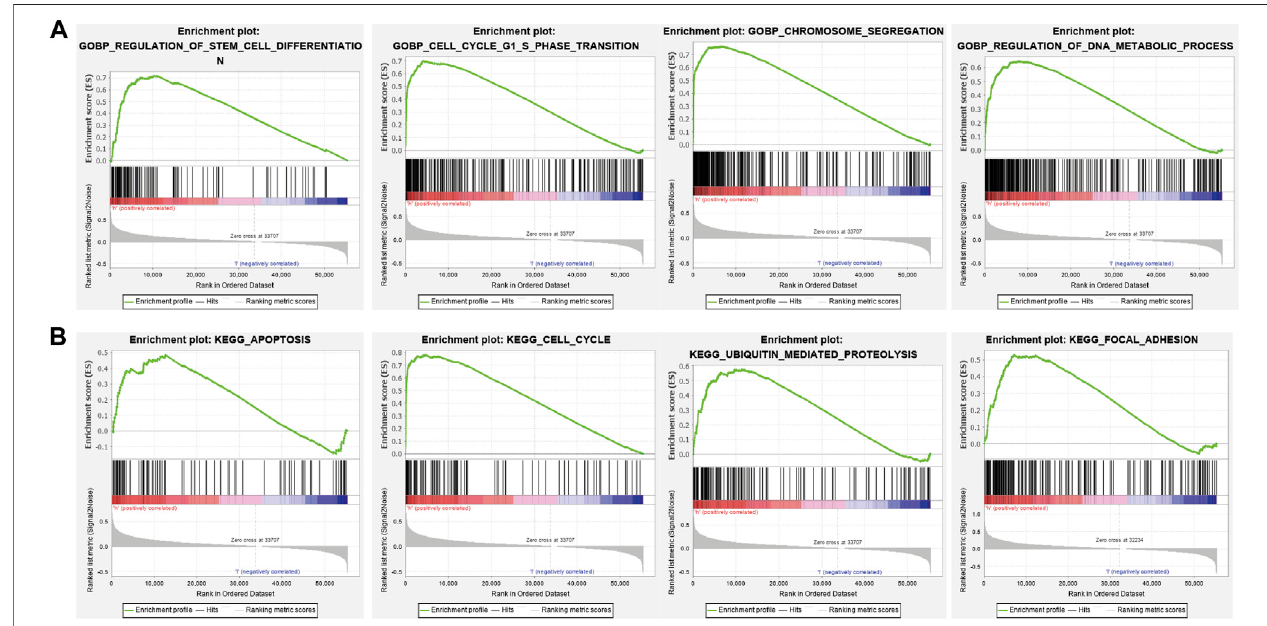
FIGURE7| TheKEGGsignalpathwayexploredbyGSEAsoftware. (A) Thebiologicalprocessinvolvedby BIRC5 inLGGwasexaminedbyGSEAsoftware. (B) The signaling pathway involved by BIRC5 in LGG was examined by GSEA software.